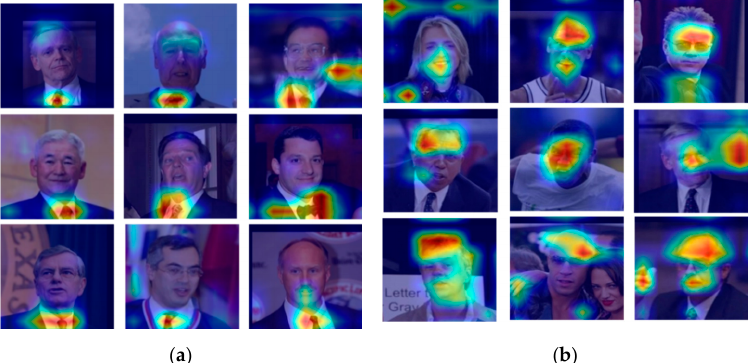
Figure 8. Visual expressions from applying Grad-CAM to user preference–classification results with LFW: ( a ) sample heat maps for the results in preferred data, and ( b ) sample heat maps for the results in non-preferred data.